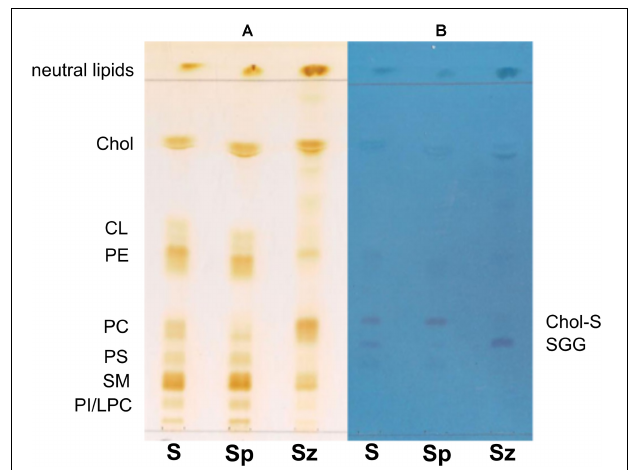
FIGURE 1 | Comparison of TLC lipid profiles of semen, seminal plasma and spermatozoa. Total lipids were extracted from whole semen ( S ) as well as from related spermatozoa ( Sz ) and seminal plasma ( Sp ) obtained from a man with normozoospermia and analyzed by TLC with the same solvent, as described in Methods. All species of lipids are stained by iodine vapor (A) ; sulfur-containing lipids are stained by azure A reagent (B) . Lipid bands are indicated by their abbreviations: phosphatidylinositol (PI), lysophosphatidylcholine (LPC), sphingomyelin (SM), phosphatidylserine (PS), phosphatidylcholine (PC), phosphatidylethanolamine (PE), cardiolipin (CL), cholesterol (Chol), cholesterol sulfate (Chol-S), and seminolipid